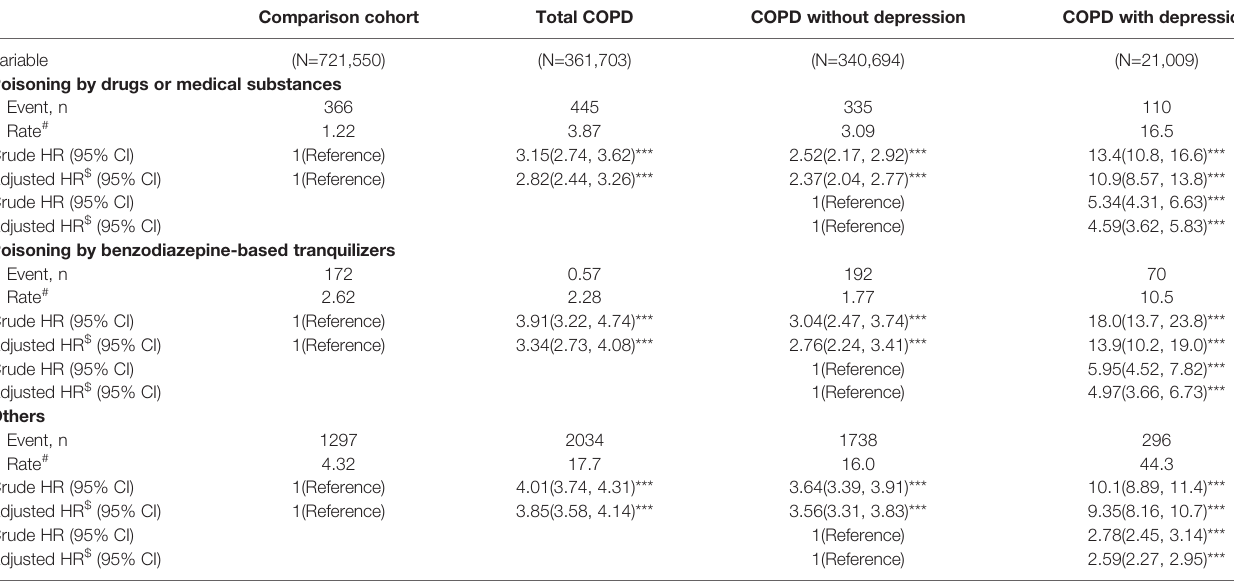
TABLE 5 | Overall incidence with different methods of suicidal drug overdose (per 10 000 person-years) and estimated hazard ratio according to copd patients with or without depression through the cox